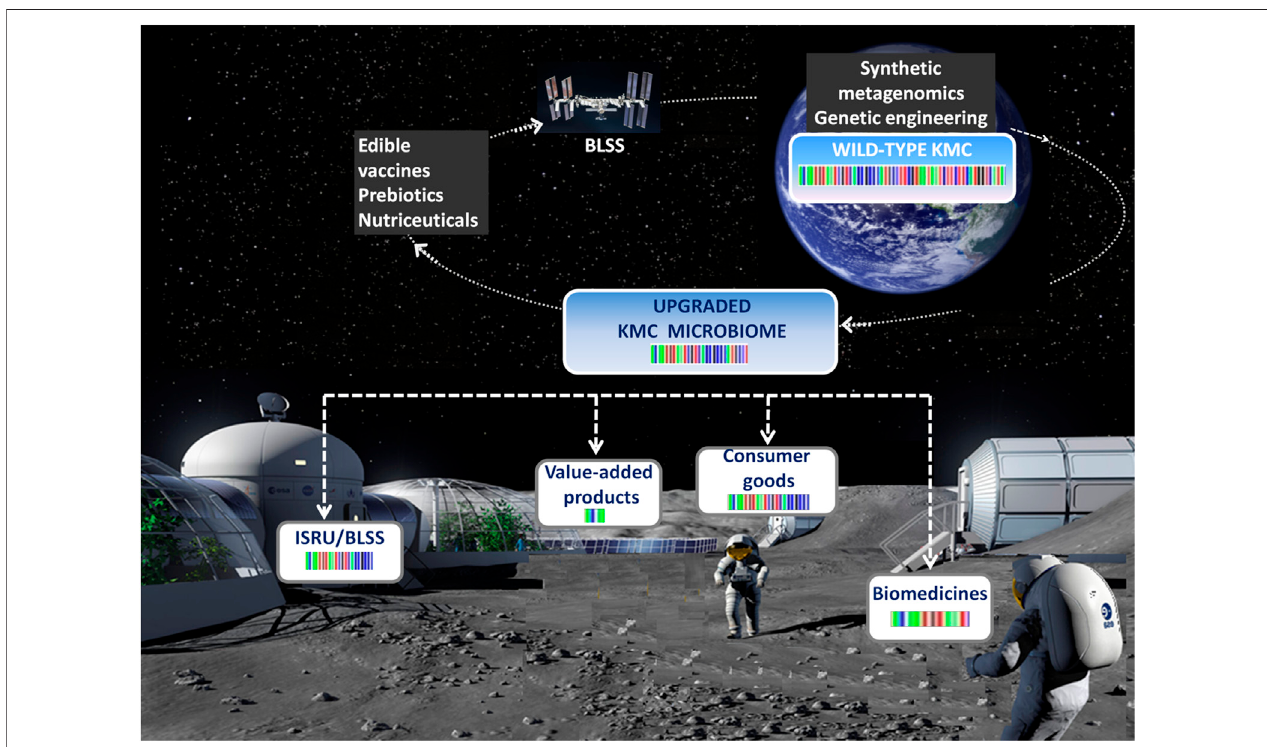
FIGURE 2 | A model scheme of the kombucha ’ s travels from the laboratory to the International Space Station and extraterrestrial settlements.